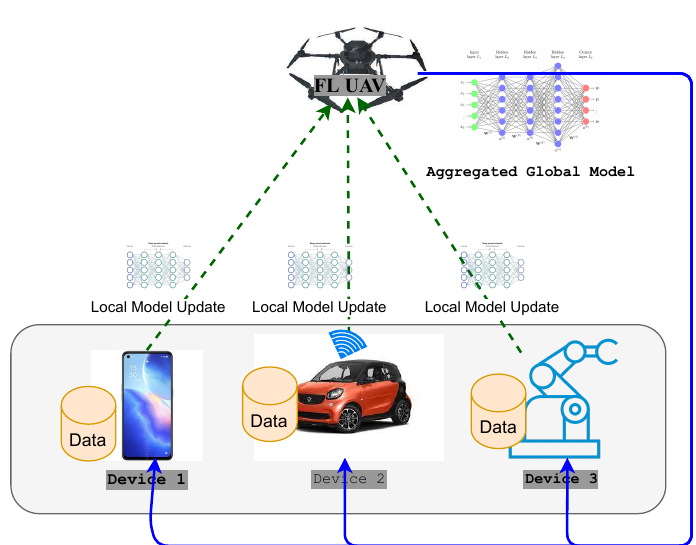
Figure 12. Federated Learning in UAVs with an edge-computing-enabled